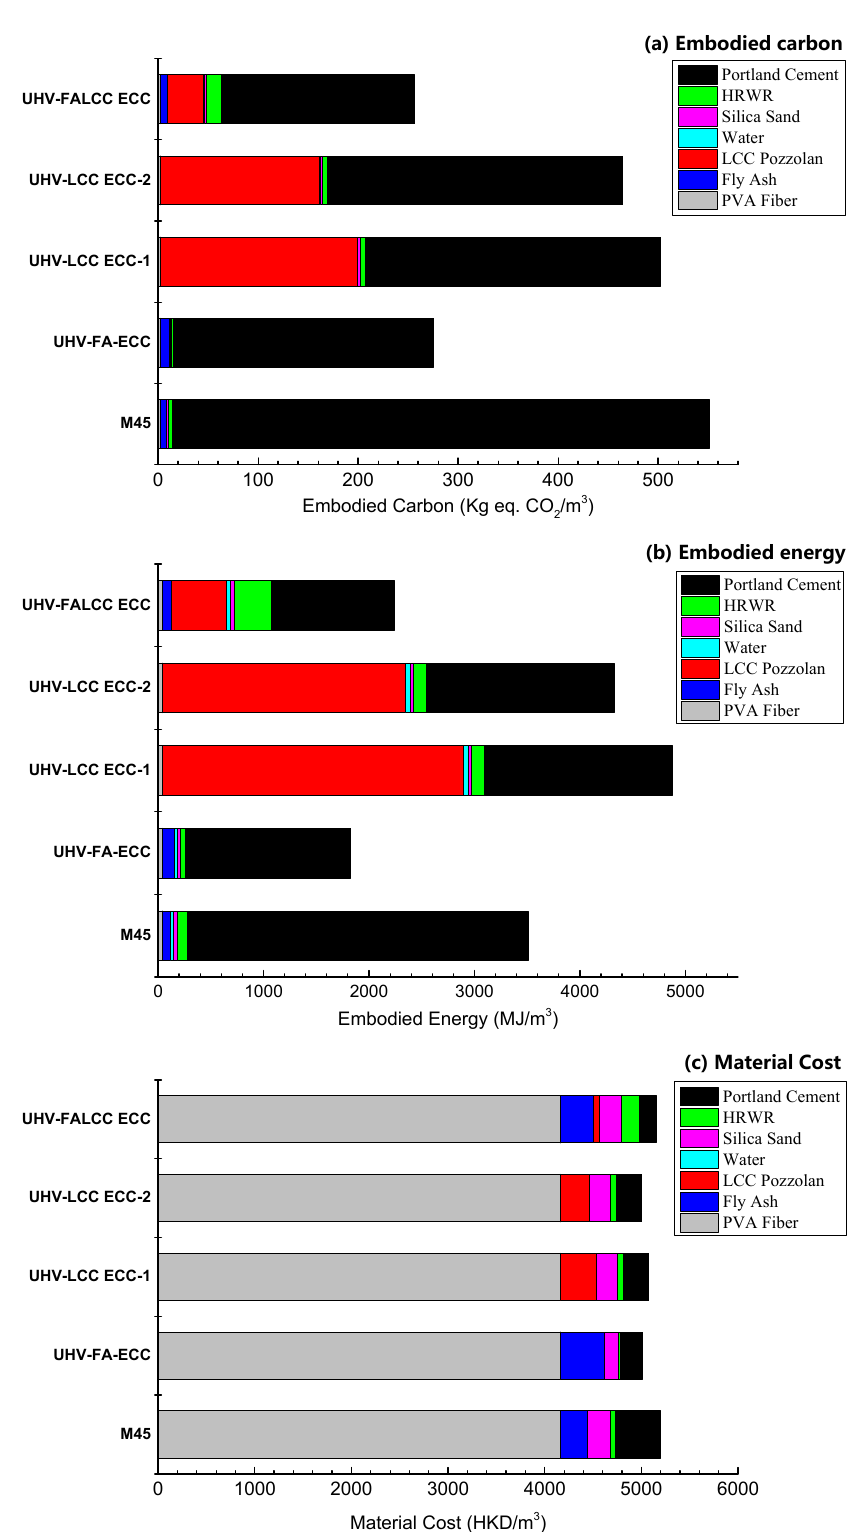
Figure 8 . Comparison of Material Sustainability Indicators (MSI) of different ECC mixes: a) Embodied carbon; b) Embodied Energy; c) Material